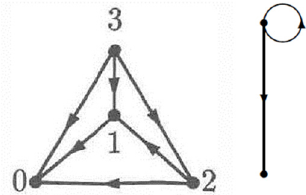
Figure 3. ( Left ) Set-tree representation of the number “3” as the root of a well-founded oriented graph of subsets satisfying von Neumann’s number construction in ZF: 0 = {} = ∅ ; 1 = { ∅ } ; 2 = { ∅ , { ∅ }} ;3 = { ∅ , { ∅ } , { ∅ , { ∅ }}} . Note that in such a representation, the empty set is the node to which all the morphisms are pointing while the unary set is always the central node (from [11], p. 3). ( Right ) Representation of a non-well-founded oriented graph where the self-containing set {{·}} (reflexive graph) is allowed by the anti-foundation axiom, and where the symbol ( · ) emphasizes that the construction holds for sets of whichever cardinality (from [75], p. 9).